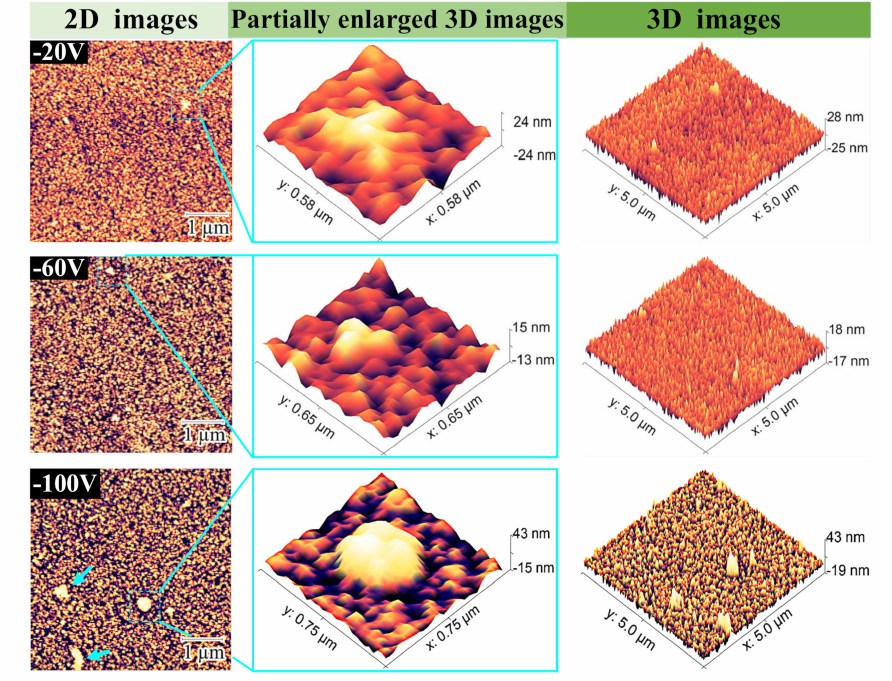
Figure 6. The 2D, 3D, and partially enlarged images of titanium nitride films deposited at substrate bias voltages of − 20 V, − 60 V, and − 100